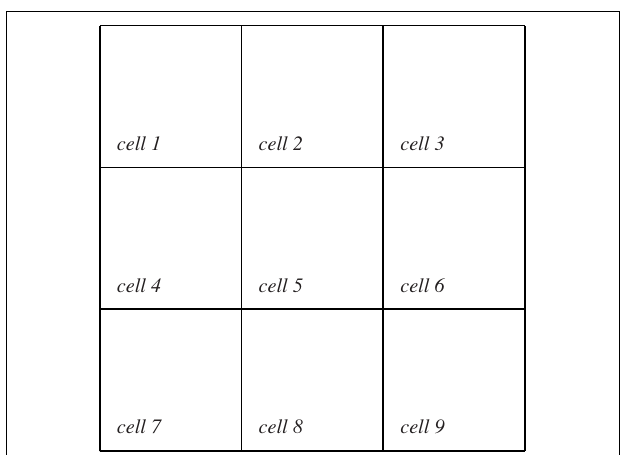
FIGURE 2 | The model domain is divided into nine cells. An SD agent is associated with each of these cells and with the domain as a whole. Any IB